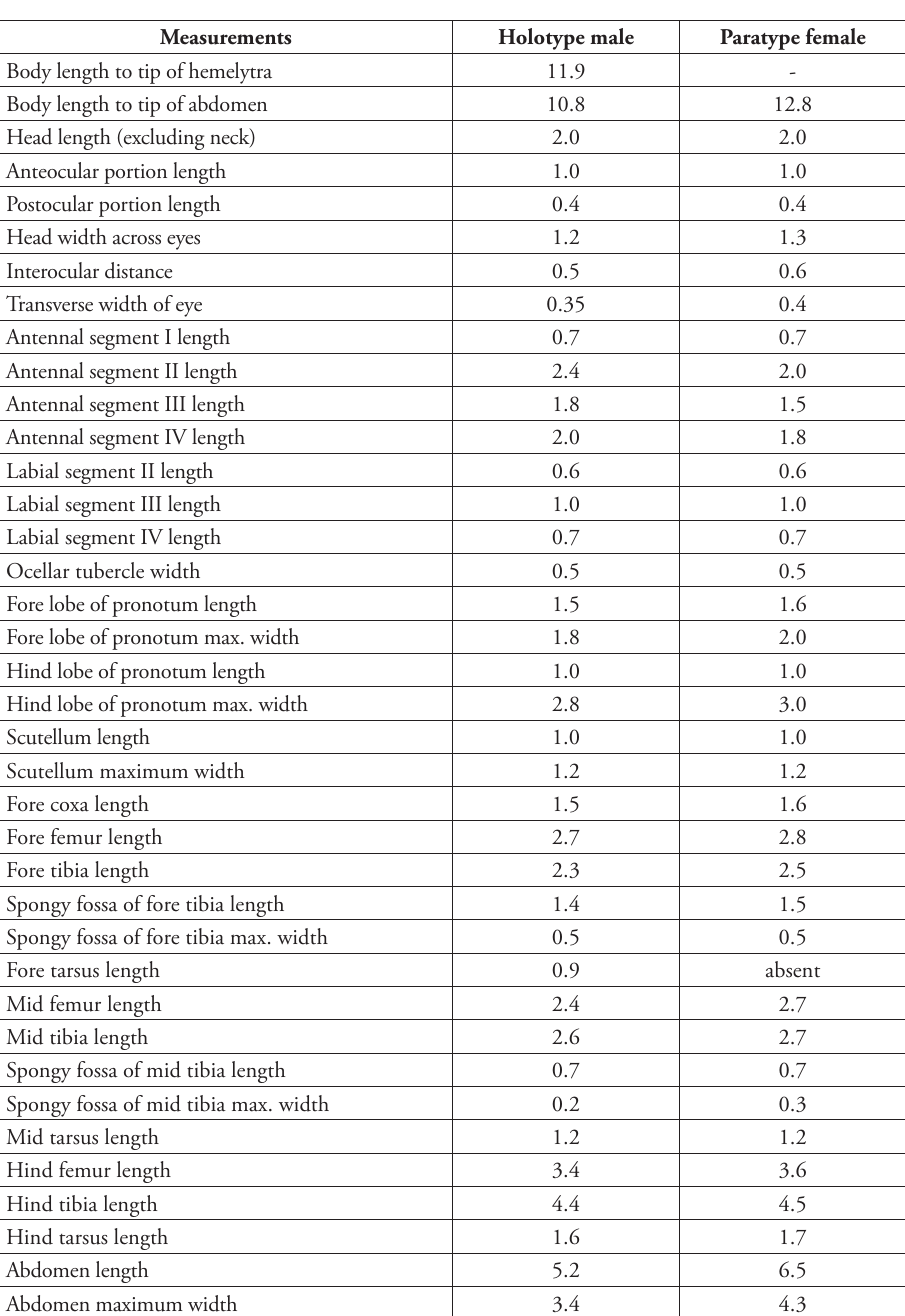
Table 1. Measurements of Zeraikia zeraikae sp.